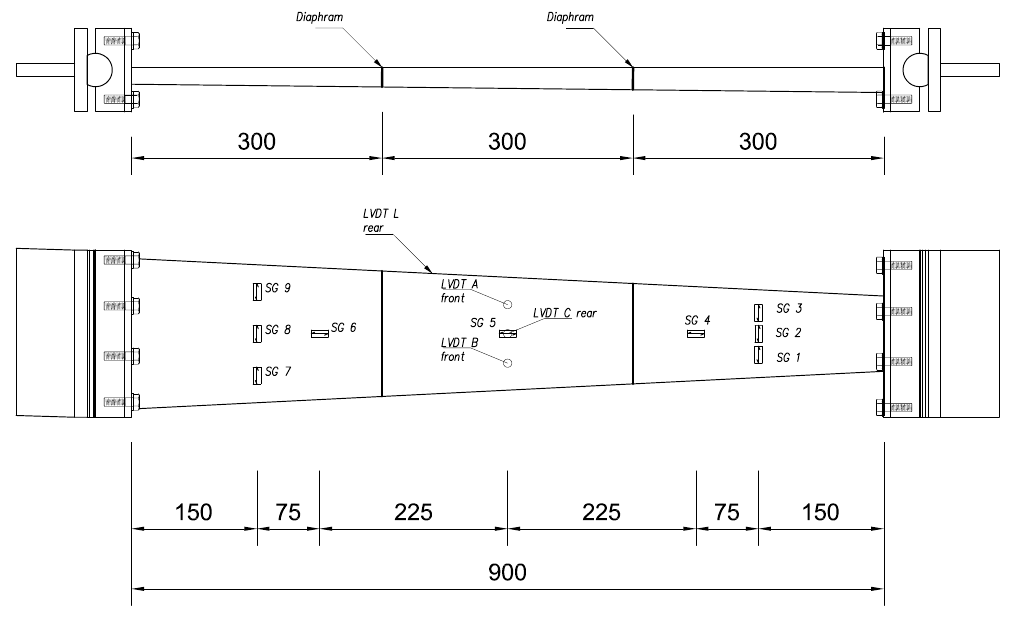
Figure 5. Instrumentation layout (unit: